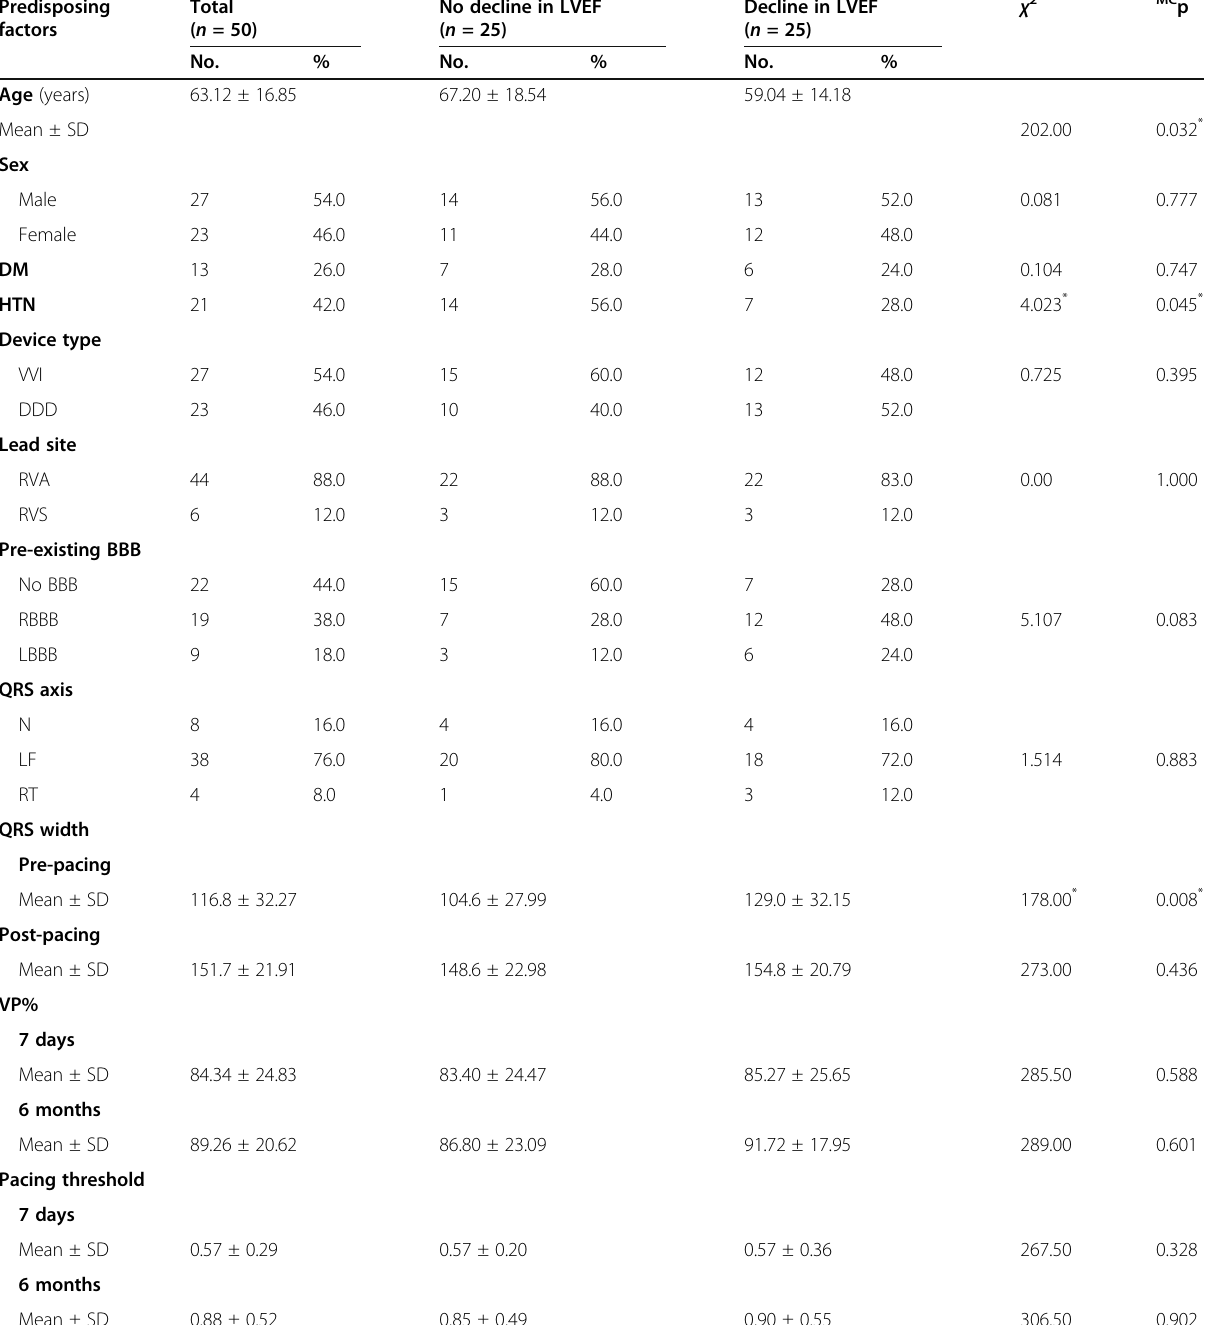
Table 3 Comparison between the two studied groups according to risk factors Predisposing